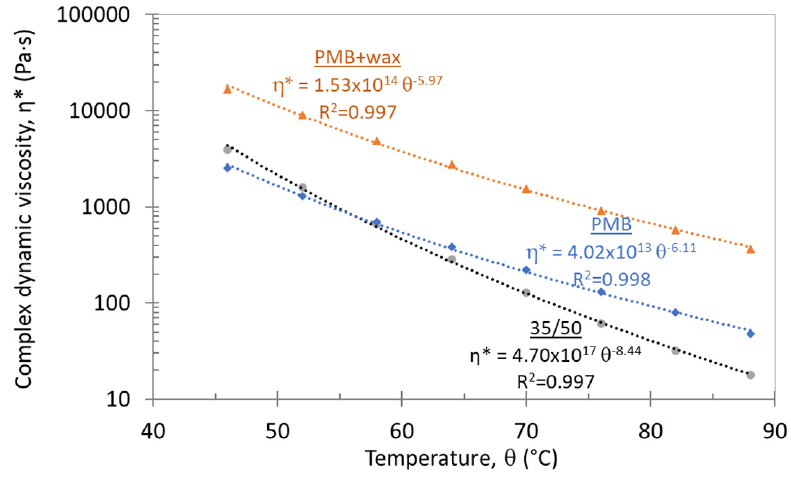
Figure 10. Complex dynamic viscosity ( η *) of three bituminous binders.